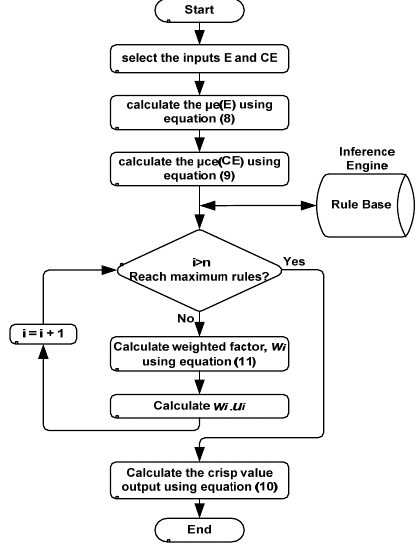
Figure 4. Encoding of the FLC.